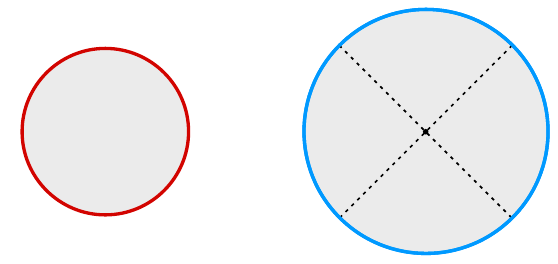
Figure 5 . Left: replica geometry for the microcanonical thermofield double state. Right: replica geometry for the fixed area